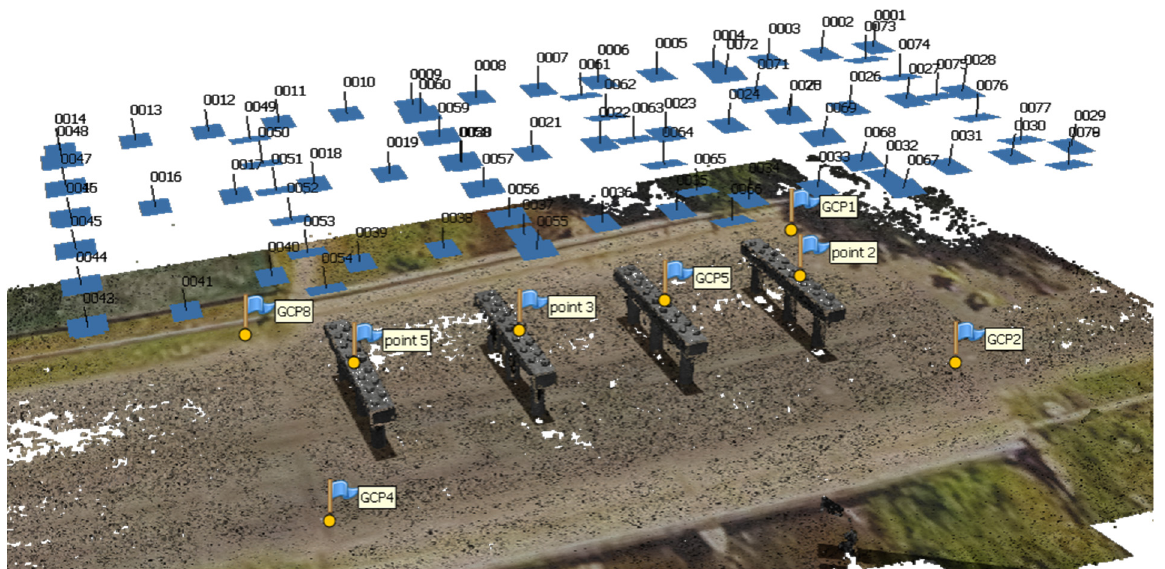
Figure 7. UAV fight plan images above the simulated scene of the pier caps.